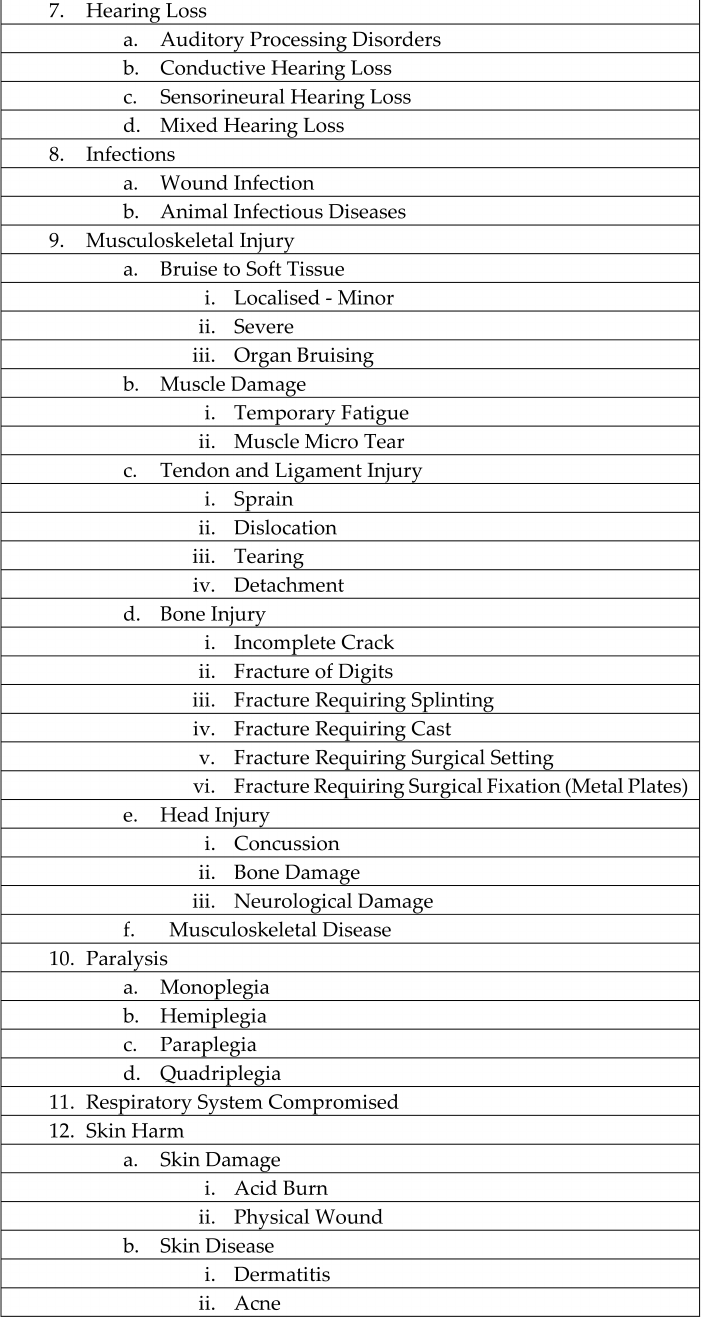
Figure 3. Biological